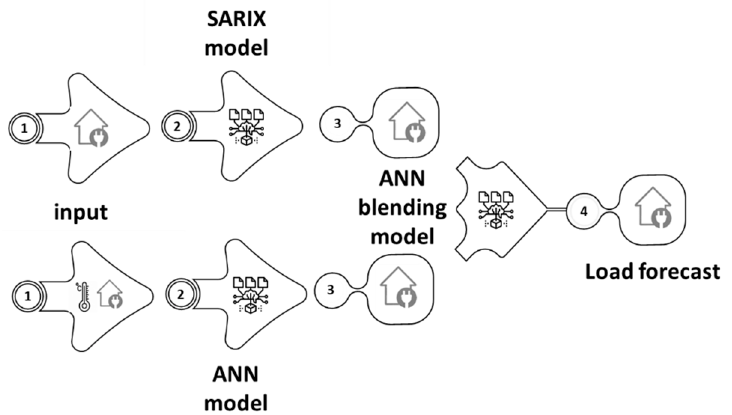
Figure 4. Diagram of the method used to predict the electric demand of each market zone.